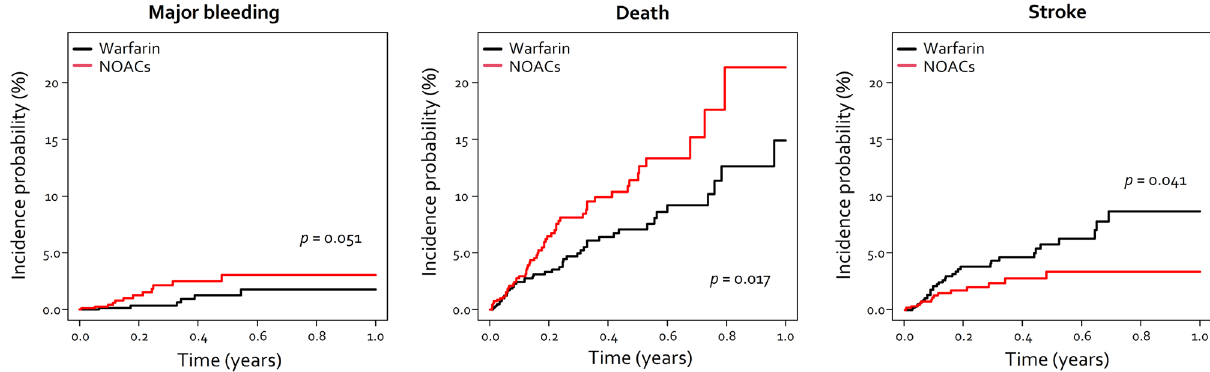
Figure 2. Crude incidence of outcomes in warfarin and NOAC users by Kaplan–Meier analysis. NOAC non- vitamin K antagonist oral